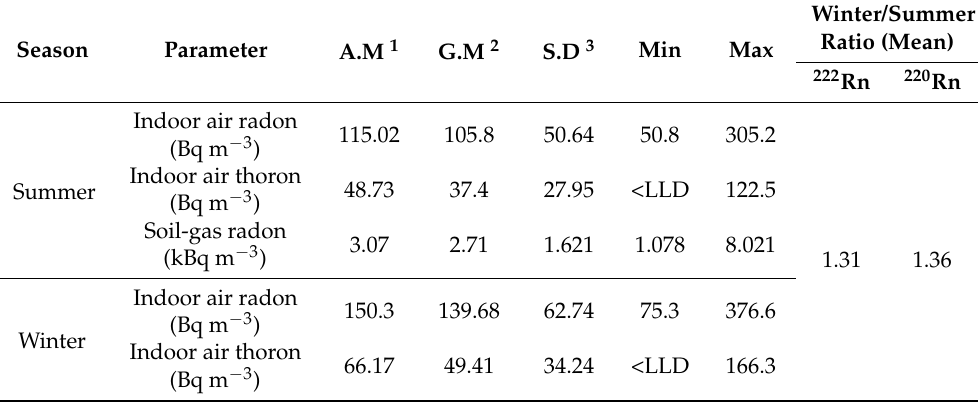
Table 1. Basic Statistics of indoor and soil gas 222 Rn and 220 Rn concentrations in samples from Mashhad.